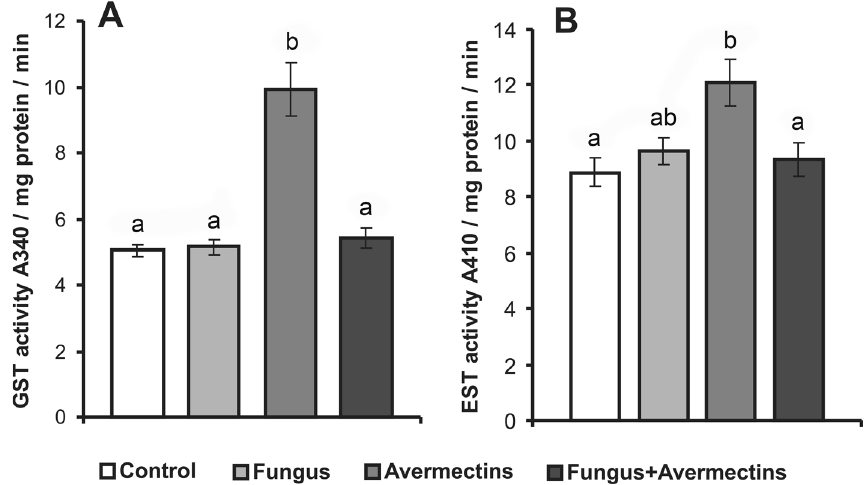
Figure 7. Changes in GST ( A ) and EST ( B ) activity in the midgut of Colorado potato beetle larvae at 48 h after topical treatment with M. robertsii conidia, oral administration of avermectins and the combined treatment. Different letters indicate significant differences between treatments (Tukey’s test, P <